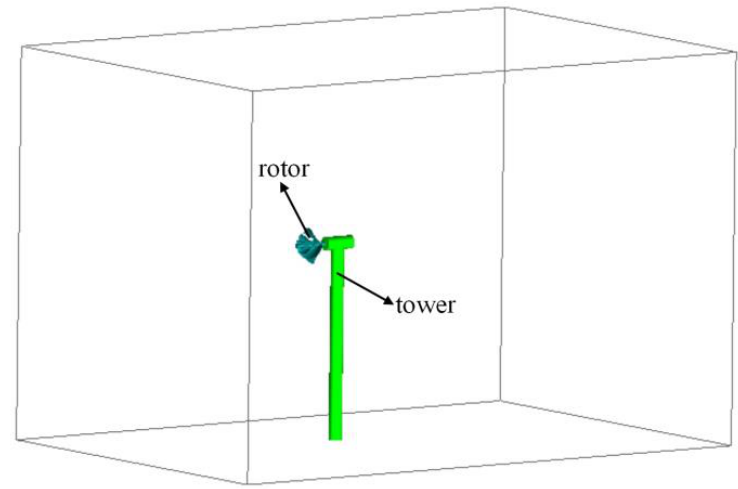
Figure 11. The ASWT rotor with a tower. Figure 12 shows the C P and C T versus time for the five ASWT rotors at TSR = 1.5. Figure 13 compares the maximum, mean and minimum values for C P and C T . The time series of C P and C T for the five ASWT rotors present obvious periodic oscillations and show the same time-periodic behavior due to the fact that the rotational speed is equal. However, there are differences in the fluctuation amplitude of the five ASWT rotors. For the C P , the fluctuation amplitude ranging in order from the large to the small are: 30-30-30, 30-45-60, 60-60-60, 45-45-45 and 15-30-45. For the C T , the fluctuation amplitude ranging in order from the large to the small are: 30-30-30, 60-60-60, 30-45-60, 45-45-45 and 15-30-45. Therefore, the ASWT with the larger blade angle has a stronger fluctuation in aerodynamic performance, which may lead to a fatigue problem on ASWT blades. The reason that the 30-30-30 has the maximum fluctuation amplitude among the five ASWT rotors is probably due to the fact thatits α 1 brings an additional aerodynamic effect. Additionally, compared with the non-tower case, the mean value on C P and C T of the tower case has decreased by 2.4% and 2.6%, respectively. The fluctuation amplitude on C P and C T has increased by 25.5% and 21.4, respectively.